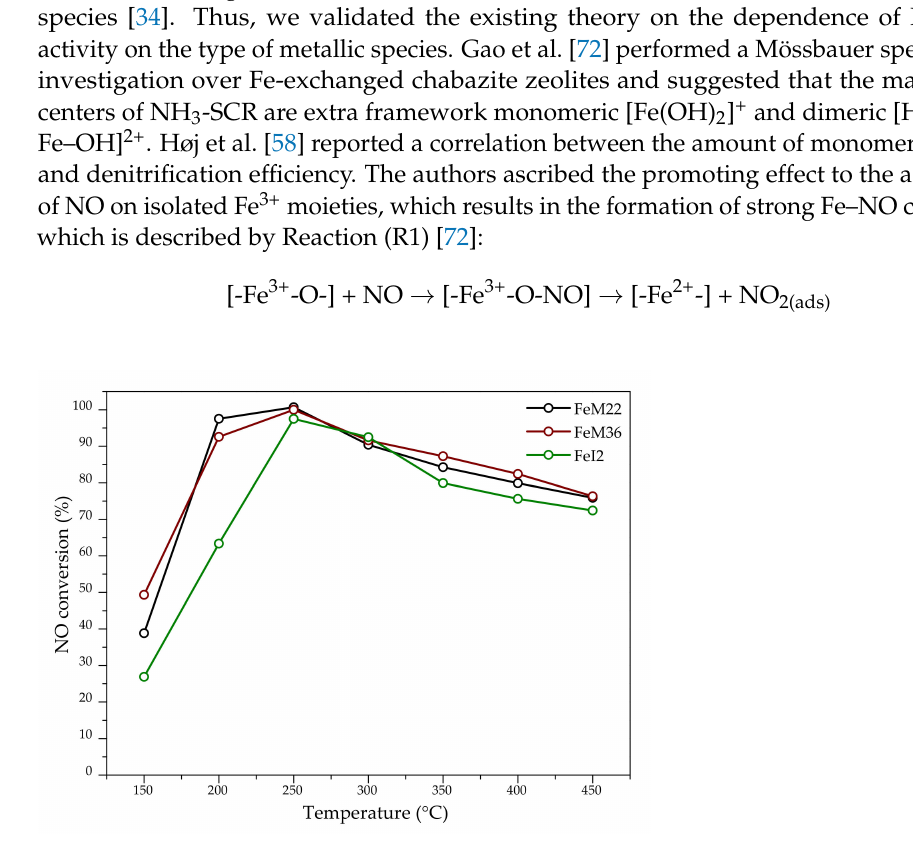
Figure 6. NO conversion obtained for the investigated one-pot synthesized Fe-MWW